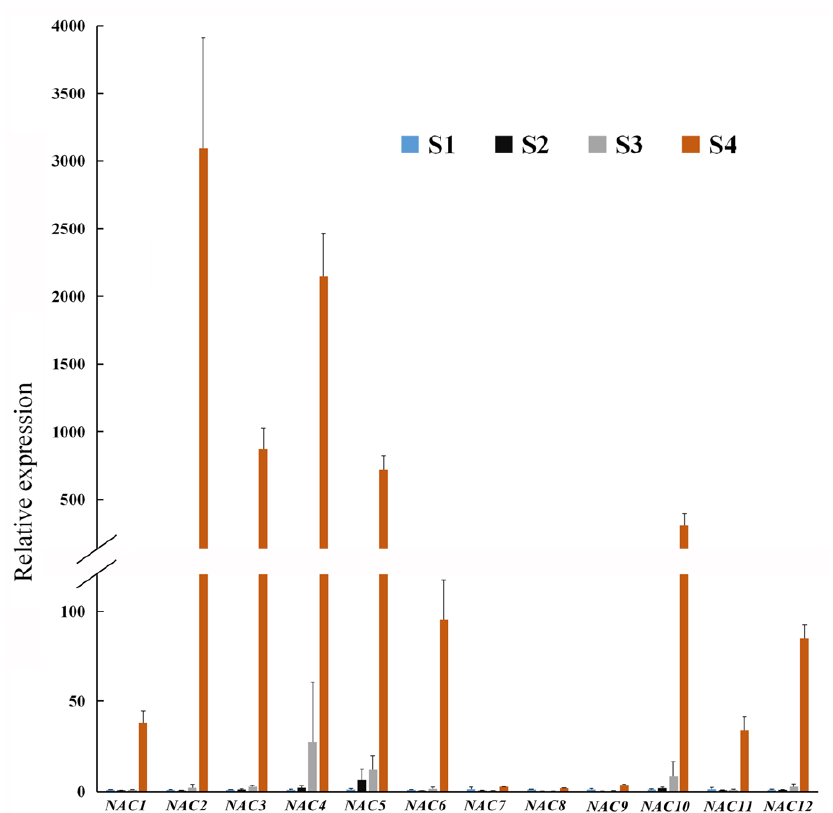
Figure 6. Expression of 12 NAC genes during flower opening by qRT-PCR analysis. The data represent the mean ± SE of three biological replicates. LoACTIN was used as the internal reference gene.